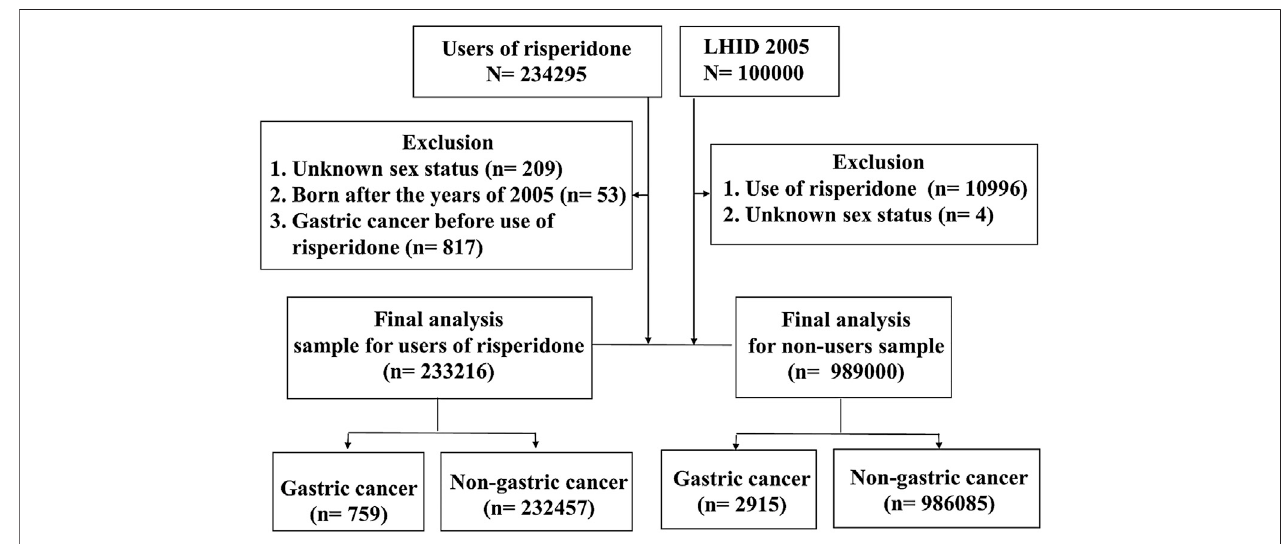
FIGURE 5 | Flow chart of participant selection in the population-based study. LHID, Longitudinal Health Insurance Database.